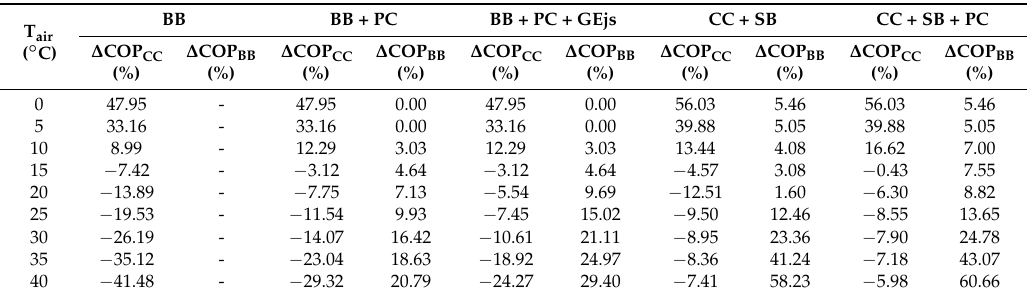
Table 2. COP variation of each architecture compared with the R513A/R744 cascade (CC) and R744 basic booster (BB).